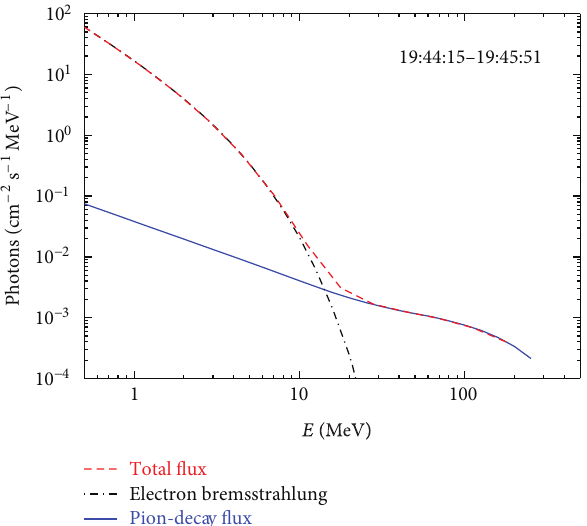
Figure 8: The restored incident gamma-ray spectrum of the flare on November 04, 2003. Red curve represents the total spectra, black curve electron bremsstrahlung component, and blue curve the pion- decay gamma-ray